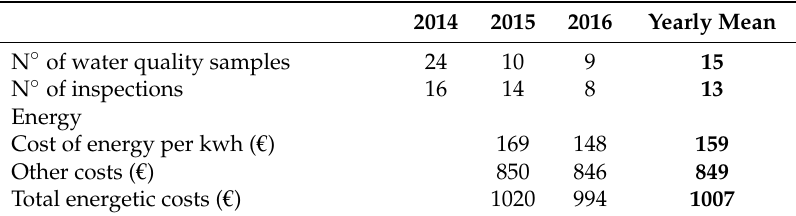
Table 4. Summarization of detailed information gained from the